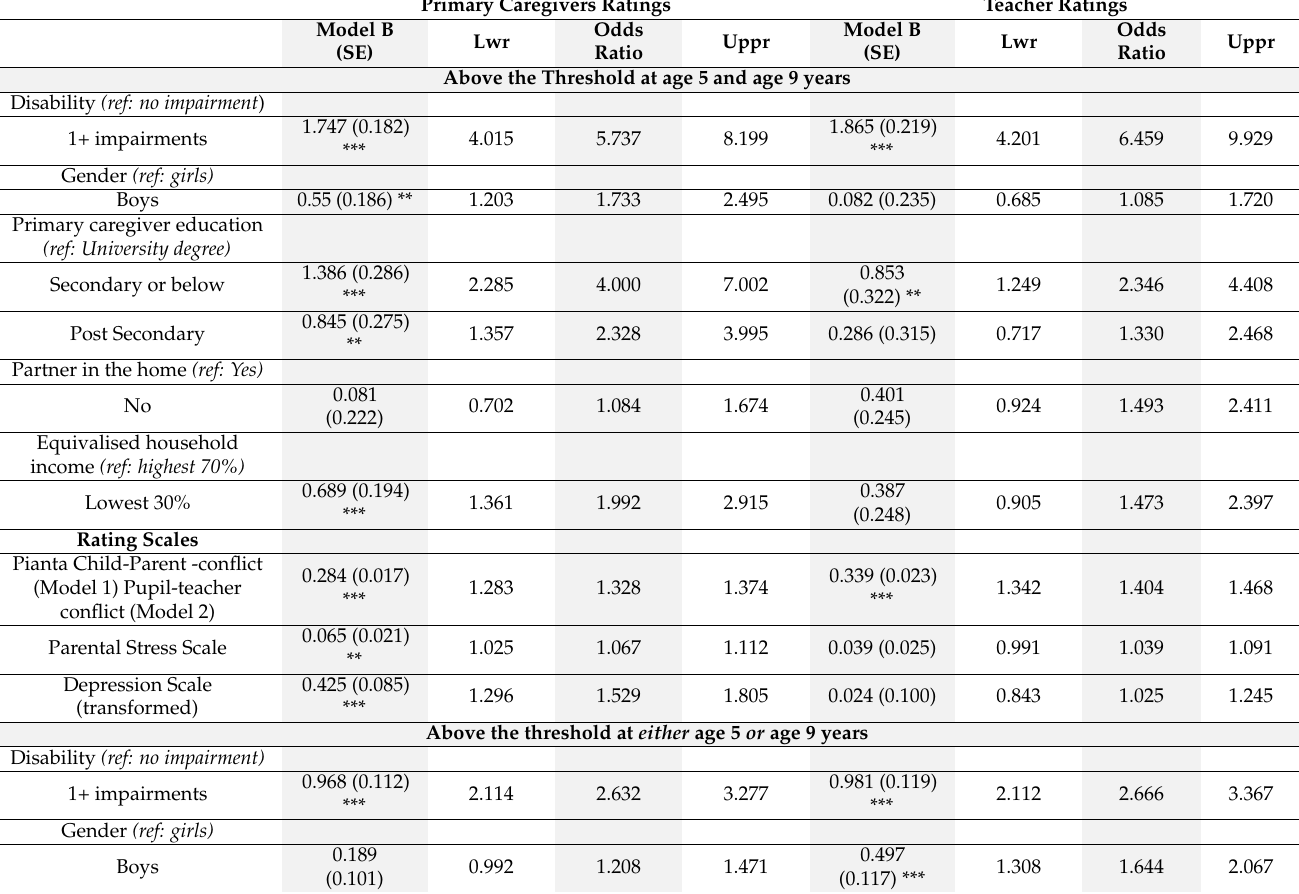
Table 3. Summary table for the Regression analysis on SDQ ratings by Primary Caregivers (PC) and by teachers. Primary Caregivers